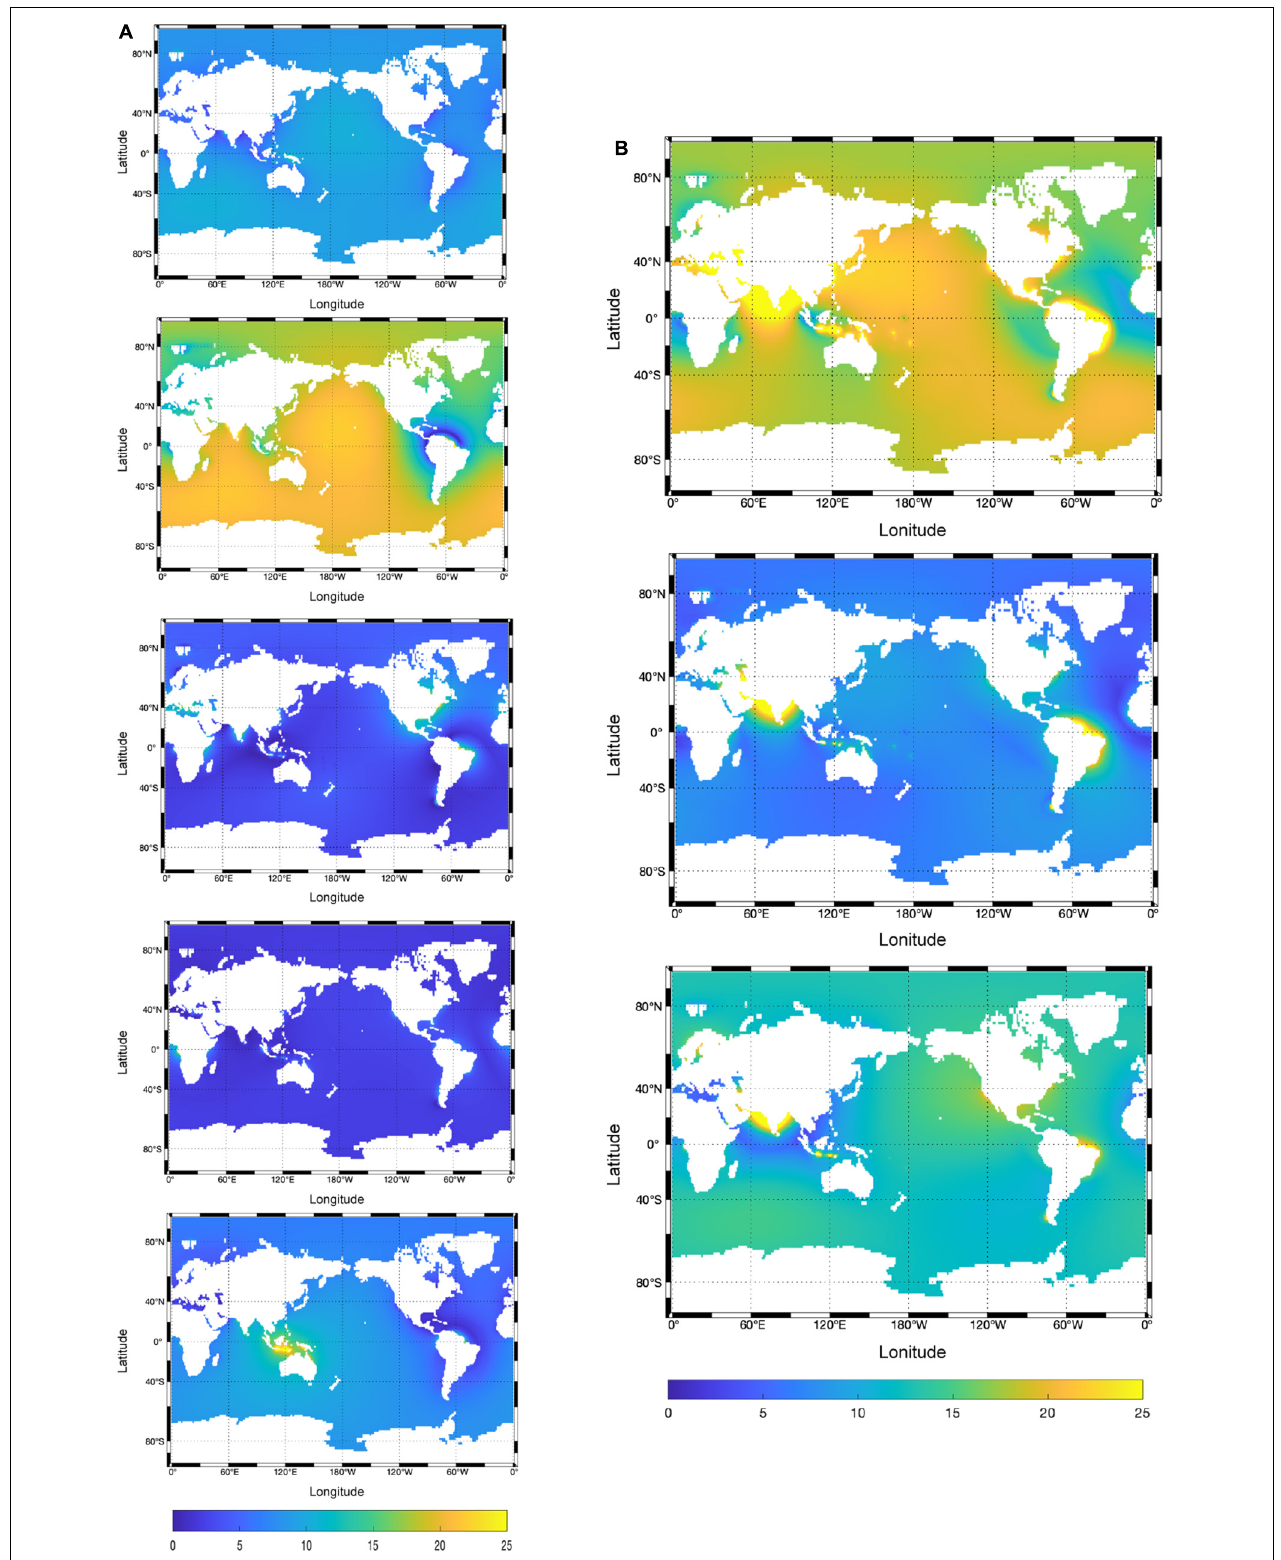
FIGURE 6 | Sea level changes (mm) between highest value and lowest value between scenarios for a given model (A) , and between models for a given scenario (B) . In panel (A) models are ordered alphabetically and in panel (B) scenarios are ordered from high-end to low-end emission scenarios from top to bottom.